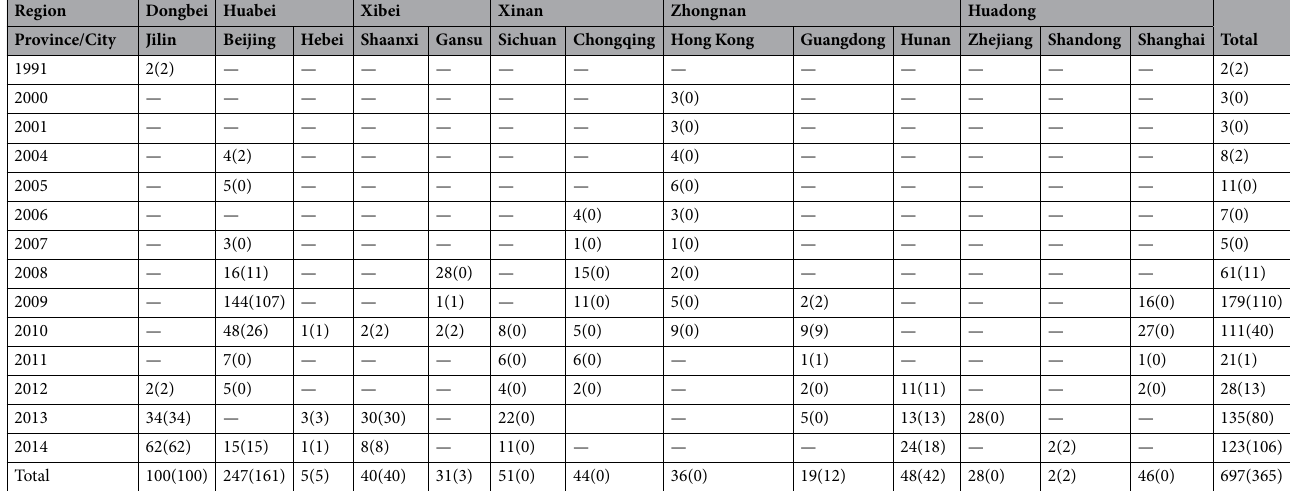
Table 1. Distribution of HRSVB samples collected in China from 1991 to 2014. Numbers shown are the sum of sequences collected in this study and those downloaded from GenBank; sequences collected in this study are shown within parentheses. The 6 representatives regions of China in our study were Dongbei (Jilin), Huabei (Beijing and Hebei), Xibei (Shaanxi and Gansu), Xinan (Sichuan and Chongqing), Zhongnan (Guangdong, Hunan and Hong Kong SAR), and Huadong (Shandong, Shanghai and